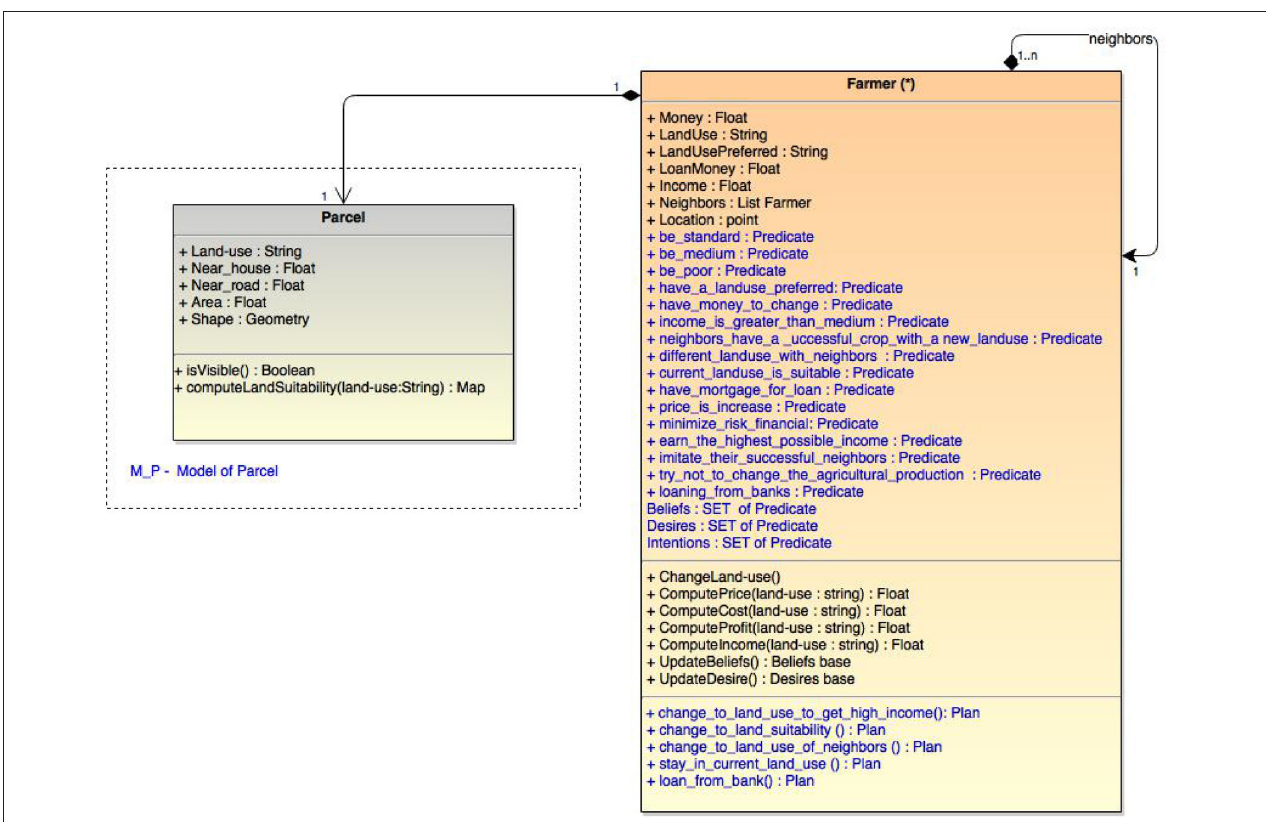
FIGURE 11 | UML representation of